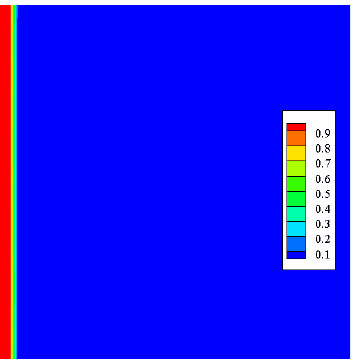
Figure 3. Contour of ice phase fraction and location of water–ice interface.